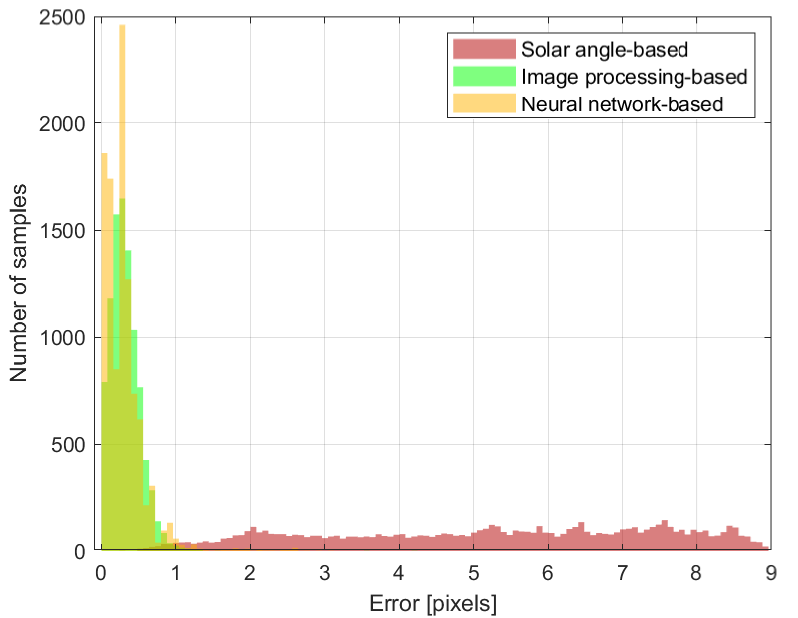
Figure 13. Distribution of errors (in pixel) of the three